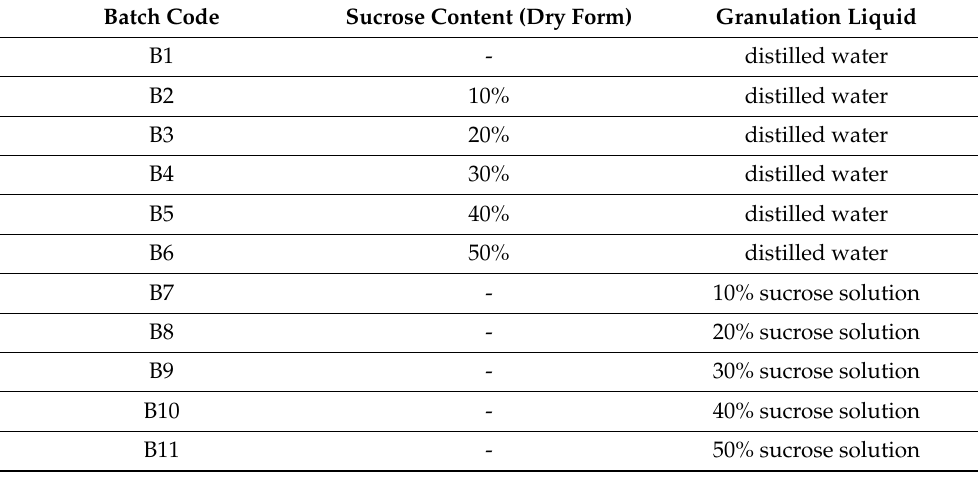
Table 1. Overview of compositions of the different batches of paper granules produced.